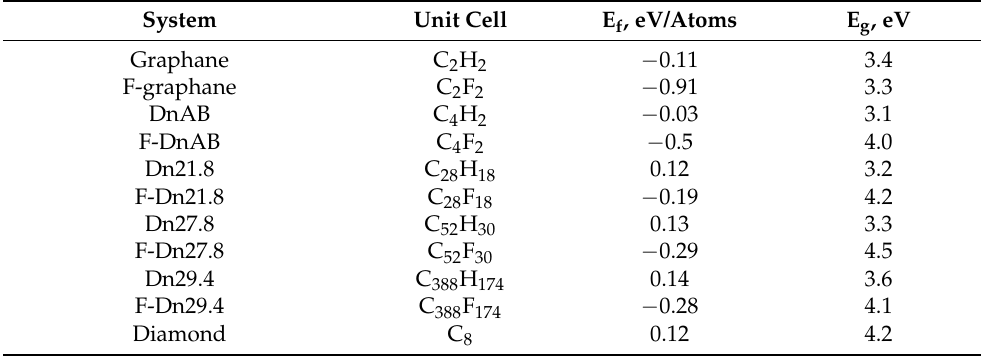
Table 3. Formation energies E f of sp 3 C M X N (X = H, F) structures relative to graphene, and bandgaps E g of the considered Moir é diamanes